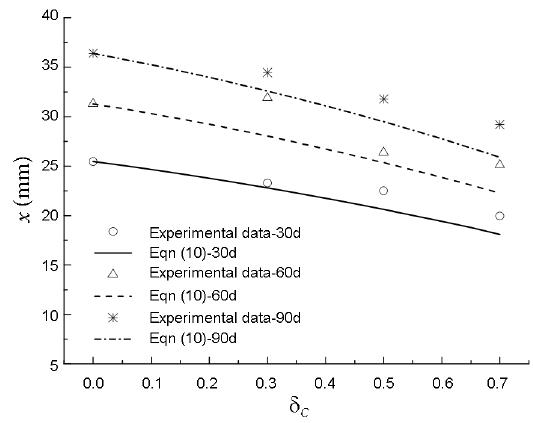
Figure 9. Comparison between the computed results from Eqn (10) and the experimental data from Liu et al. (2004)